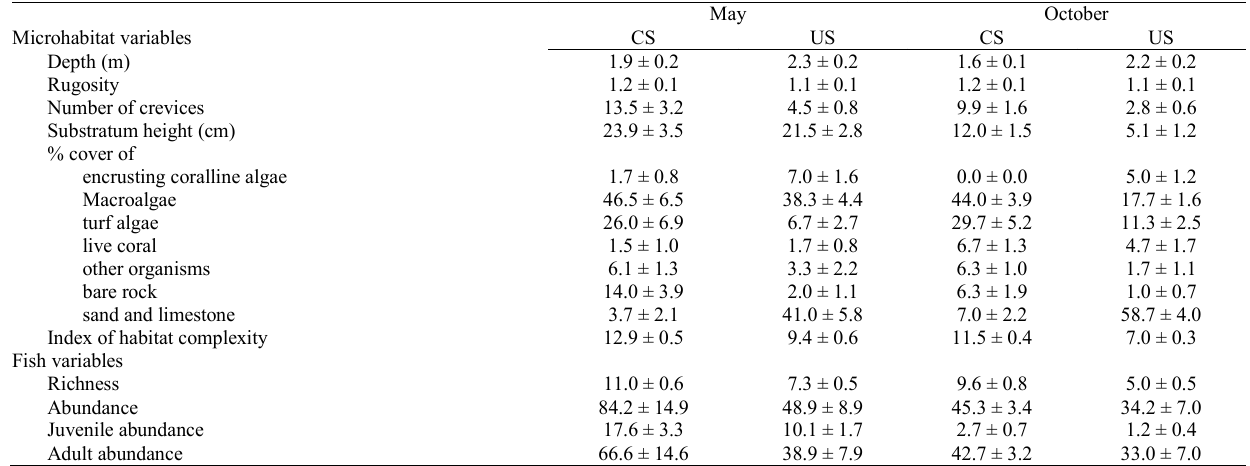
Table 2. Mean values (±SE) of microhabitat and fish variables from underwater visual census at 15 permanent consolidated substratum